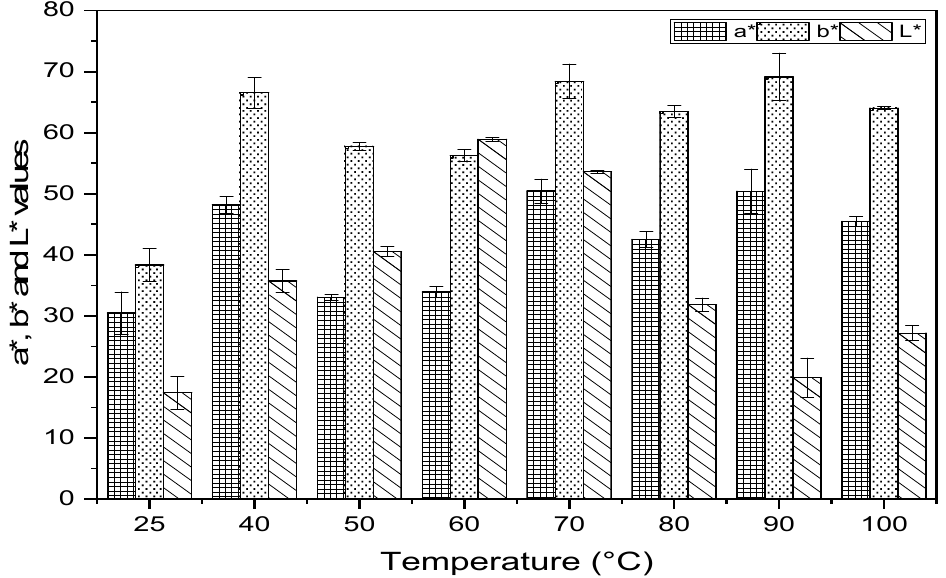
Figure 1. Impact of temperature on the color (values a*, b* and L*) of the powder of the argan pulp.